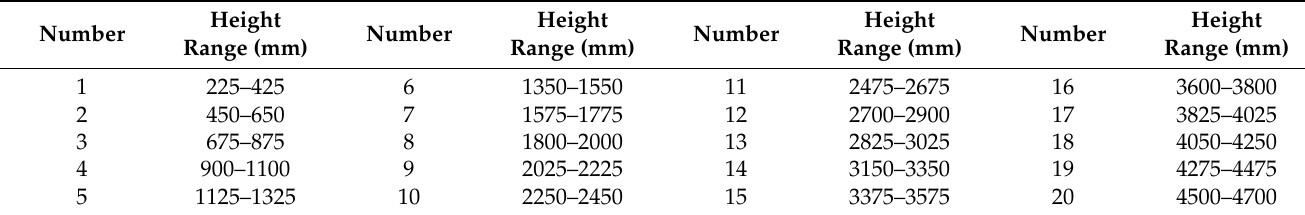
Figure 1. Experimental equipment and experimental ground. Table 1. The height parameters of collecting plate of vertical